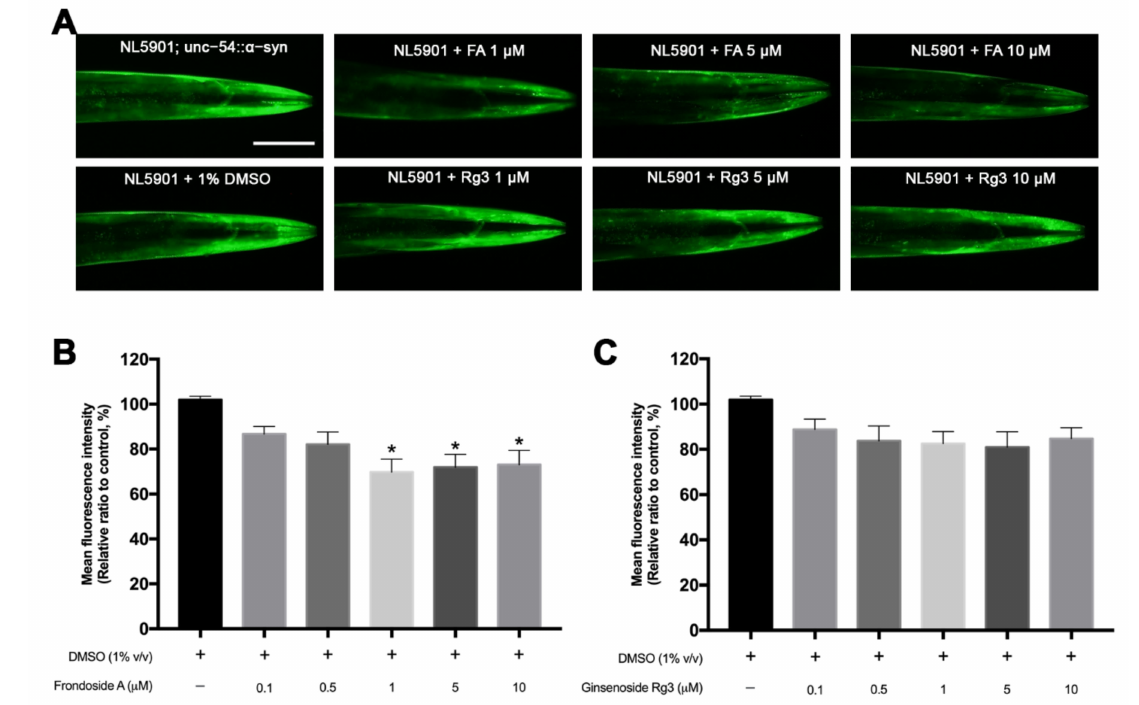
Figure 5. Effects of FA and Rg3 on reduction of α -synuclein accumulation in C. elegans NL5901 strain. ( A ) YFP expression of the α -synuclein accumulation in muscles of normal NL5901, NL5901 treated with various doses of FA or Rg3. Scale bar, 50 µ m. ( B , C ) Graphical representations for MFI of YFP expression of α -synuclein accumulation treated with FA ( B ) and Rg3 ( C ) as measured by using ImageJ software. The asterisk (*) indicates a significant difference between the control DMSO-treated worms and the FA- or Rg3-treated worms ( p < 0.05). The experiment was performed independently at least three times (number of worms = 40–50 animals/group per replicate).